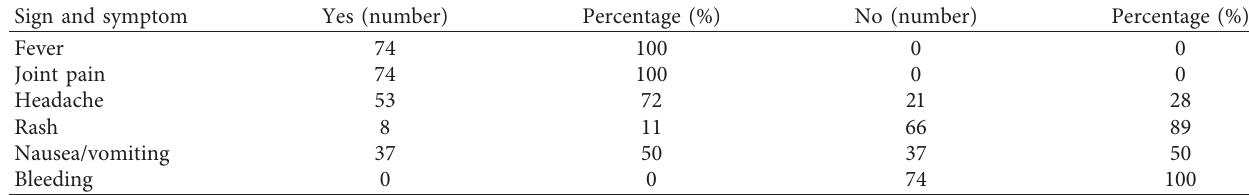
Table 3: Distribution of chikungunya cases by sign and symptoms in Kebridahar City Administration, Somali, Ethiopia, 2019. Sign and symptom